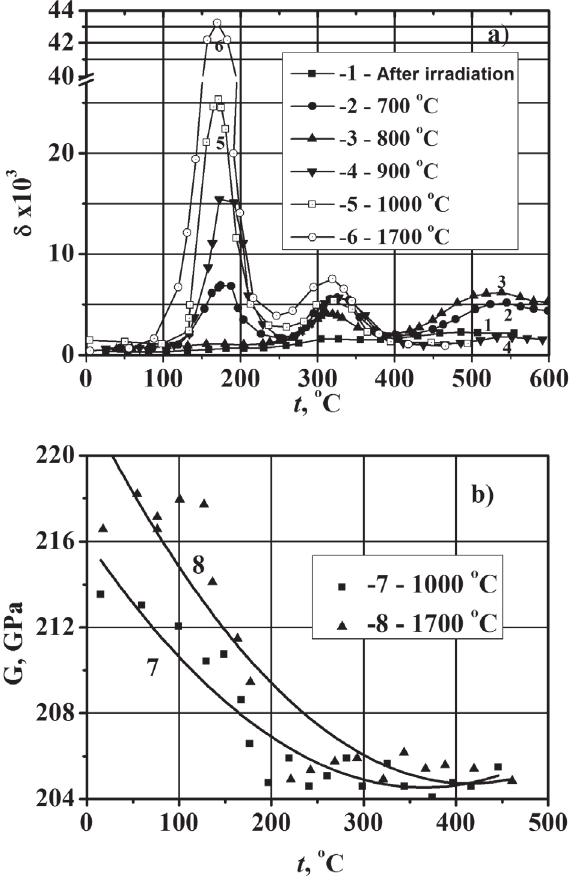
Figure 5. Dependences of the parameters of niobium samples with the <111> orientation on isochronous annealing tempera- tures: a) – internal friction ∆; b) – shear modulus G.